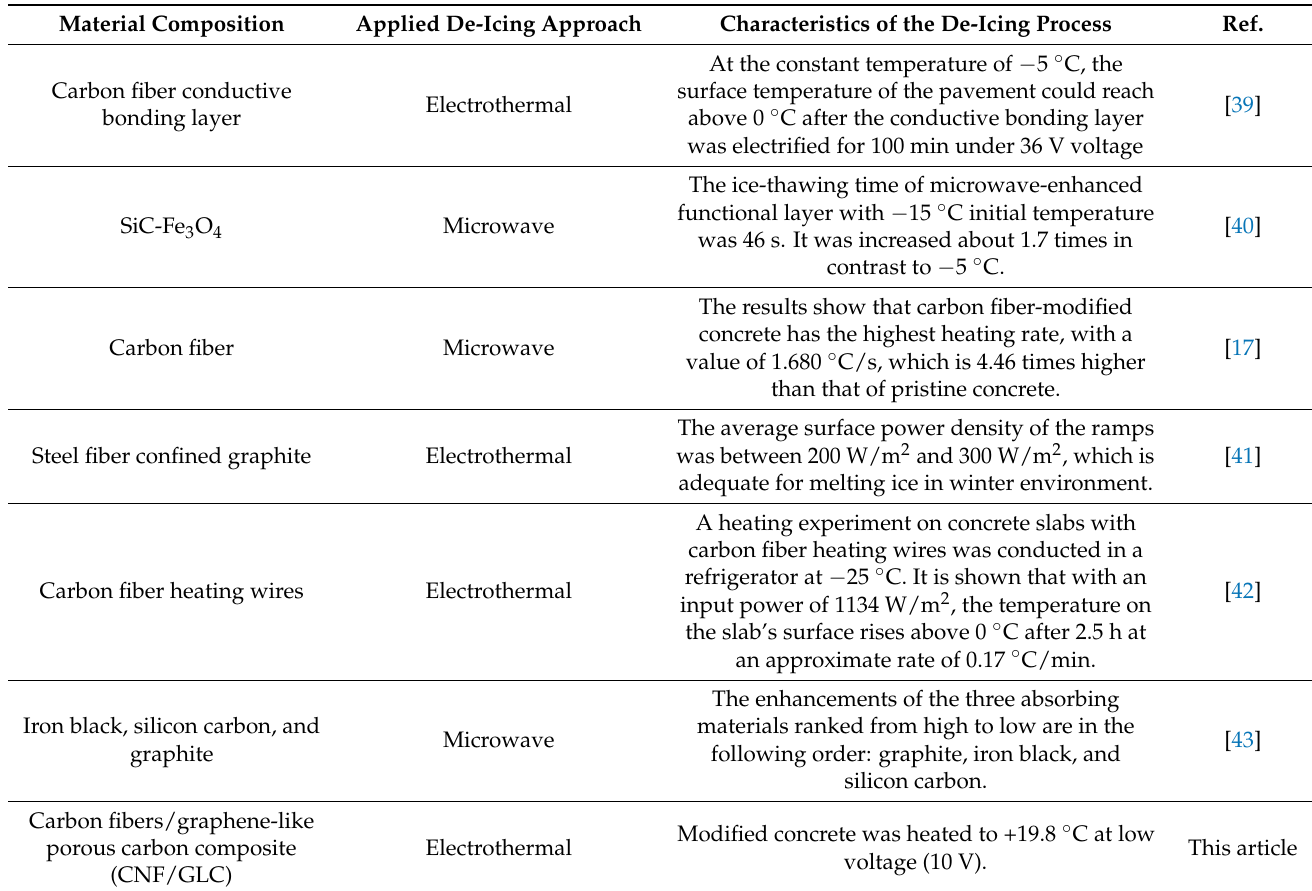
Table 3. Thermal method in concrete